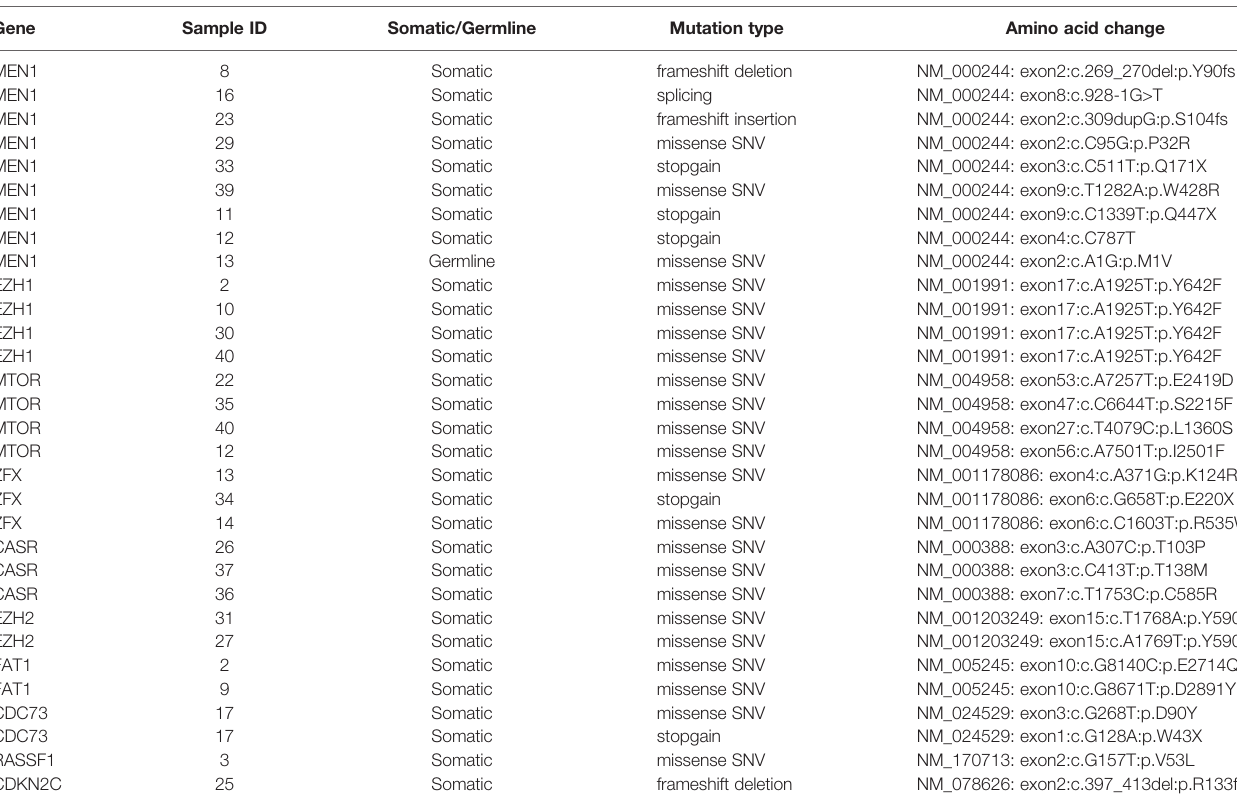
TABLE 1 | Recurrently mutated genes and potential driver genes in parathyroid adenomas. Gene Sample ID Somatic/Germline Mutation type Amino acid